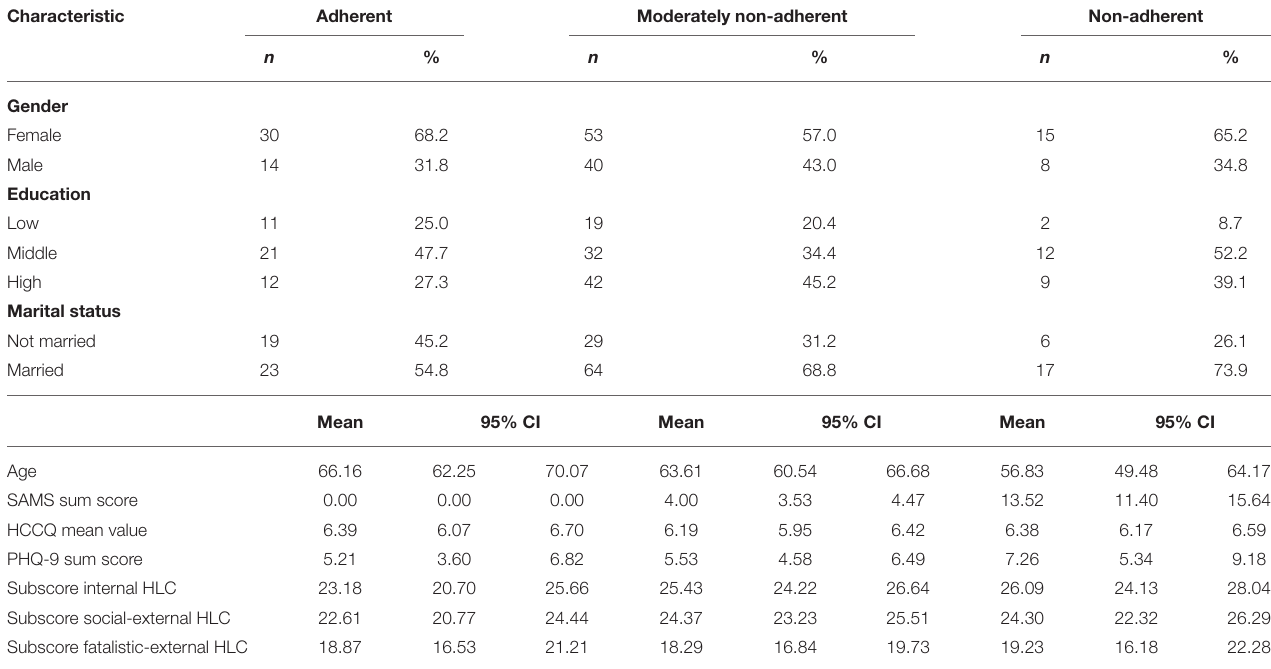
TABLE 3 | Characteristics of people with different degrees of non-adherence. Characteristic Adherent Moderately non-adherent